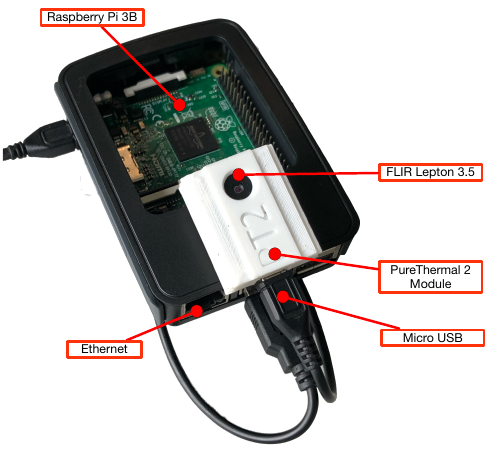
Figure 11. Hardware components of the mist